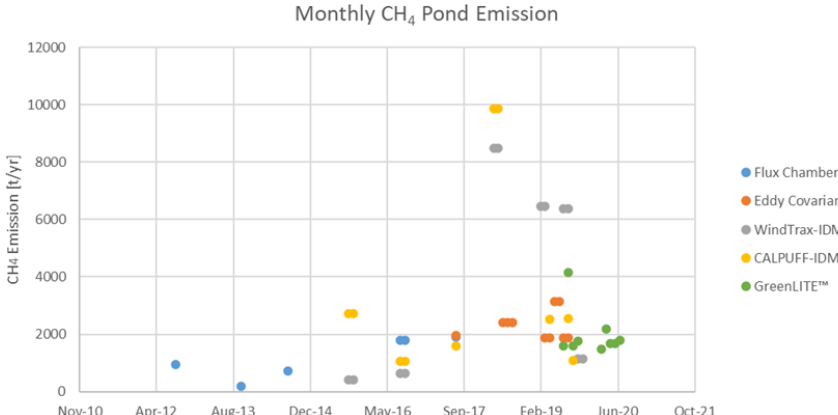
Figure 7. Historical tailings pond emission studies.